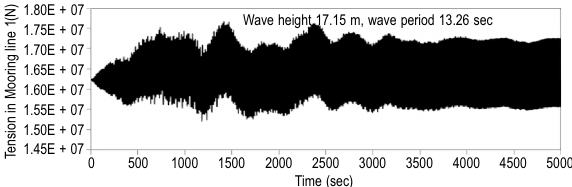
Fig. 6. Spar translational motion response in heave direction